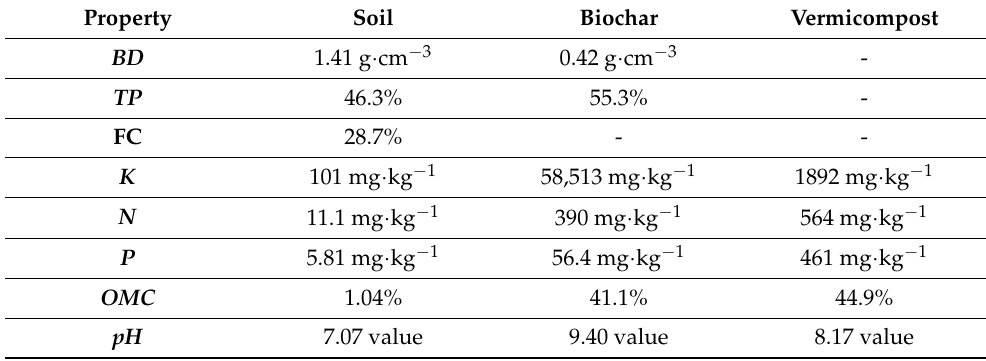
Table 2. Specific physicochemical properties of soil, biochar, and vermicompost. Property